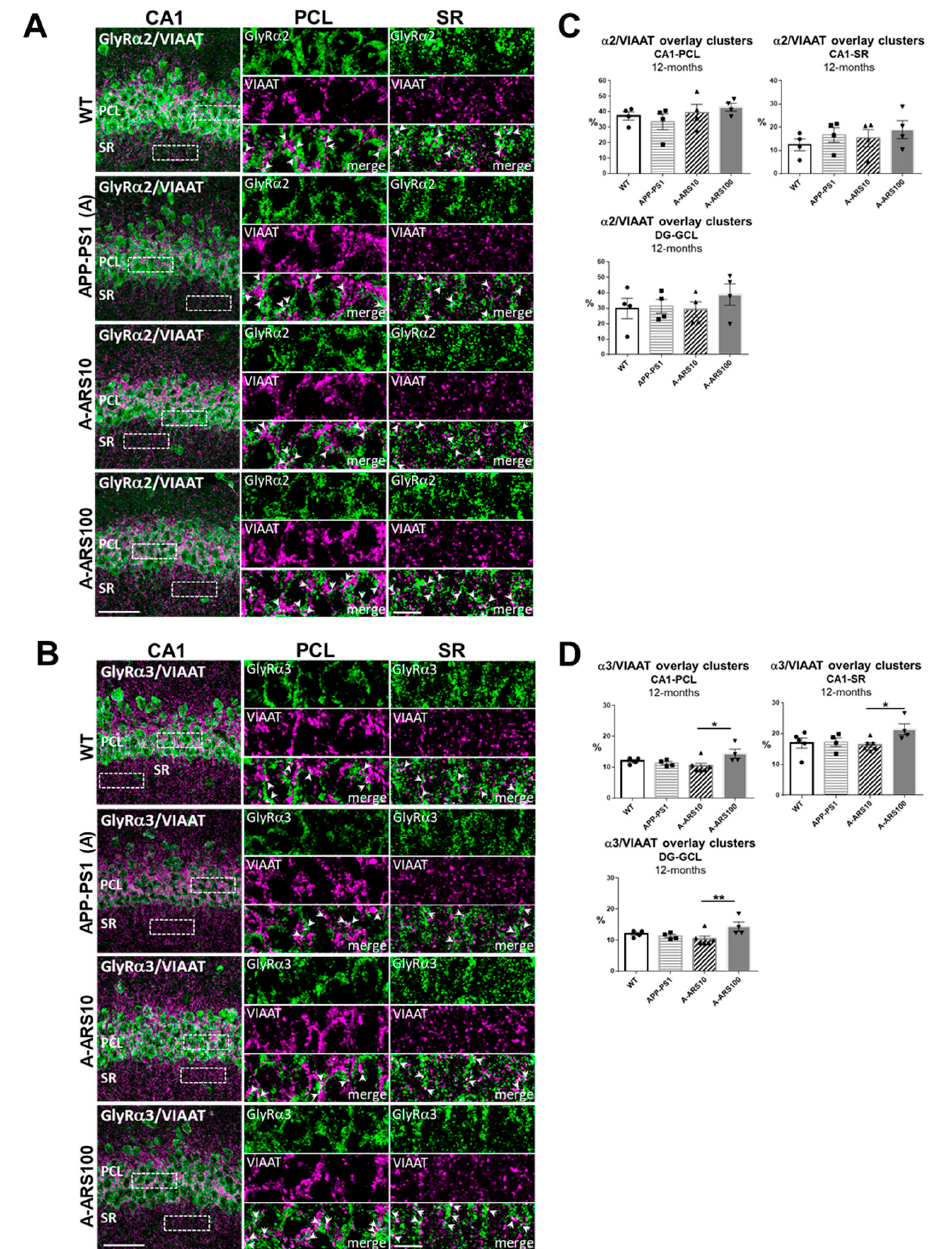
Figure 5. Subcellular localization of GlyR α 2 and GlyR α 3 clusters in hippocampus sections of 12- month-old WT and APP/PS1 mice. ( A , B ) Representative double channel IF images of the CA1 region of WT, APP/PS1 and APP/PS1 mice treated with two different doses (10 mg/kg and 100 mg/kg) of artesunate (A-ARS10, A-ARS100). Brain cryosections were double labeled with an anti-GlyR α 2 ( A ) or anti-GlyR α 3 ( B ) (green) and an anti-VIAAT (magenta) antibody. Right rectangular panels are magnifications of the boxed windows within the pyramidal cell layer (PCL) and the stratum radiatum (SR) of the CA1 region, respectively, showing single channel acquisitions (GlyR α 2 ( A ), GlyR α 3 ( B ), VIAAT) and merged images. Arrows in merged images point to overlapping puncta, indicating putative synaptic localized GlyR α 2 and GlyR α 3 clusters. Confocal maximum intensity projections (8 optical sections, 3.5- µ m thick z-stack; rectangular panels—2 optical sections, 1- µ m thick z-stack); scale bars: 50 µ m; panels: 10 µ m. ( C , D ) Quantitative analyses of GlyR α 2 ( C ) and GlyR α 3 ( D ) subunits overlapping VIAAT immunoreactivities in hippocampus areas of 12-month-old WT and APP/PS1 mice. Slices were double labeled with an anti-GlyR α 2 or anti-GlyR α 3 and an